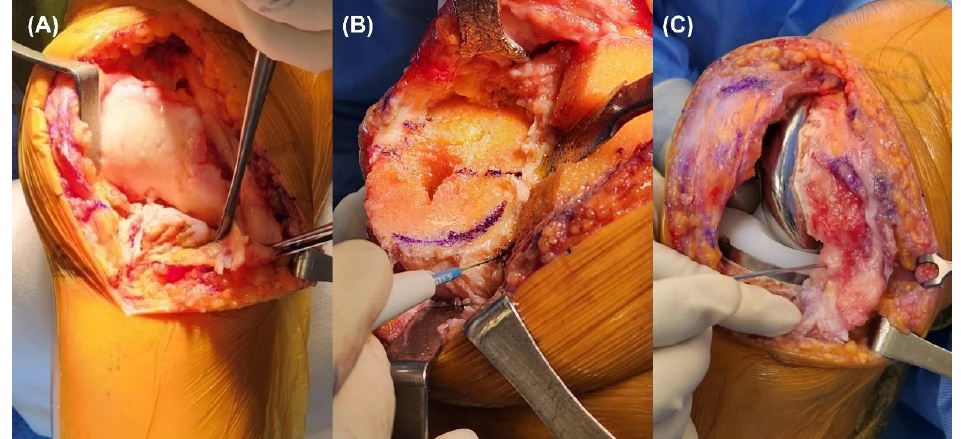
Figure 1. Sequential medial soft tissue release. ( A ) Deep medial collateral ligament release was routinely performed. When medial soft tissue is still tight after meticulous osteophyte removal and bone cutting, ( B ) releasing of tibial insertion of the semimembranosus was performed. ( C ) Pie-crusting technique for medial collateral ligament using 18-gauge needle was performed as the previous method.